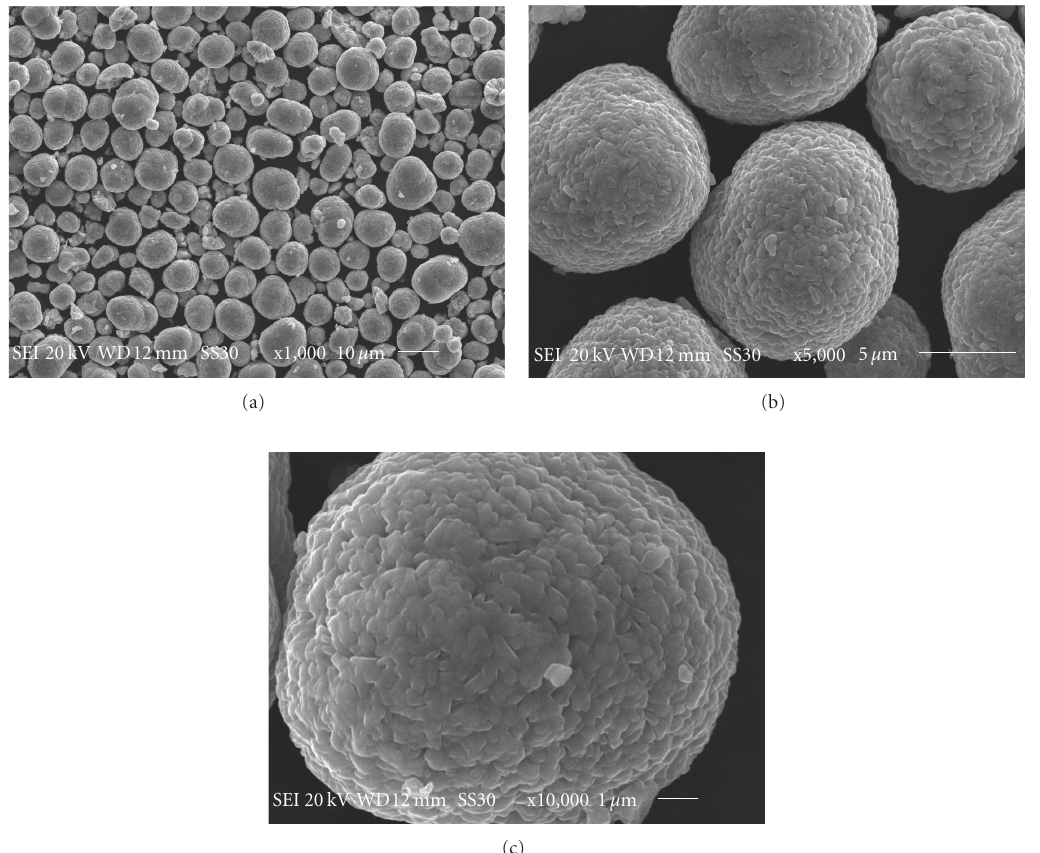
Figure 6: SEM images of the prepared Li[Ni 0 . 5 Mn 0 . 3 Co 0 . 2 ]O 2 at di ff erent magnifications (a) 500X, (b) 5000X, and (c) 10,000X.